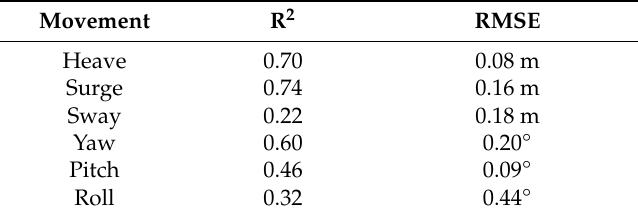
Table 11. Obtained values of the R 2 coefficient and the root mean square error (RMSE) in transfer functions validation.